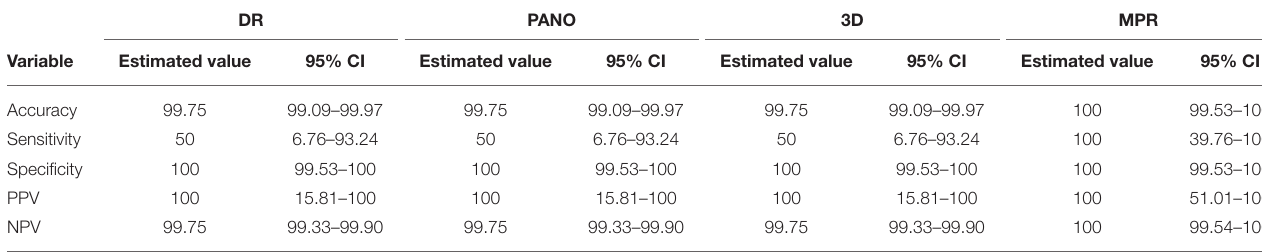
TABLE 4 | Ability to identify abnormally shaped roots in cats by use of dental radiography (DR method) and 3 CBCT software modules * .